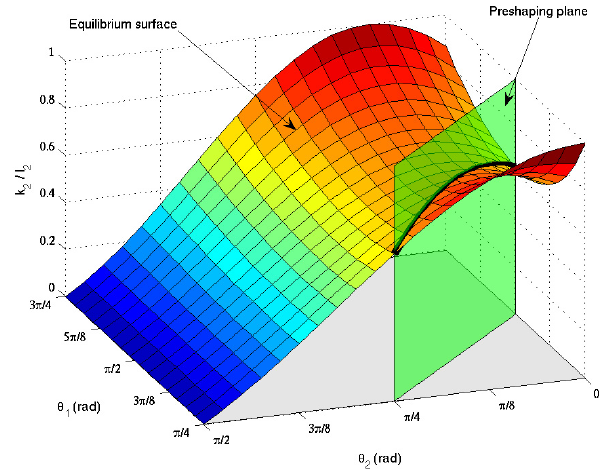
Figure 10. Equilibrium surface of the optimal design of two-phalanx finger with pinch preshaping.